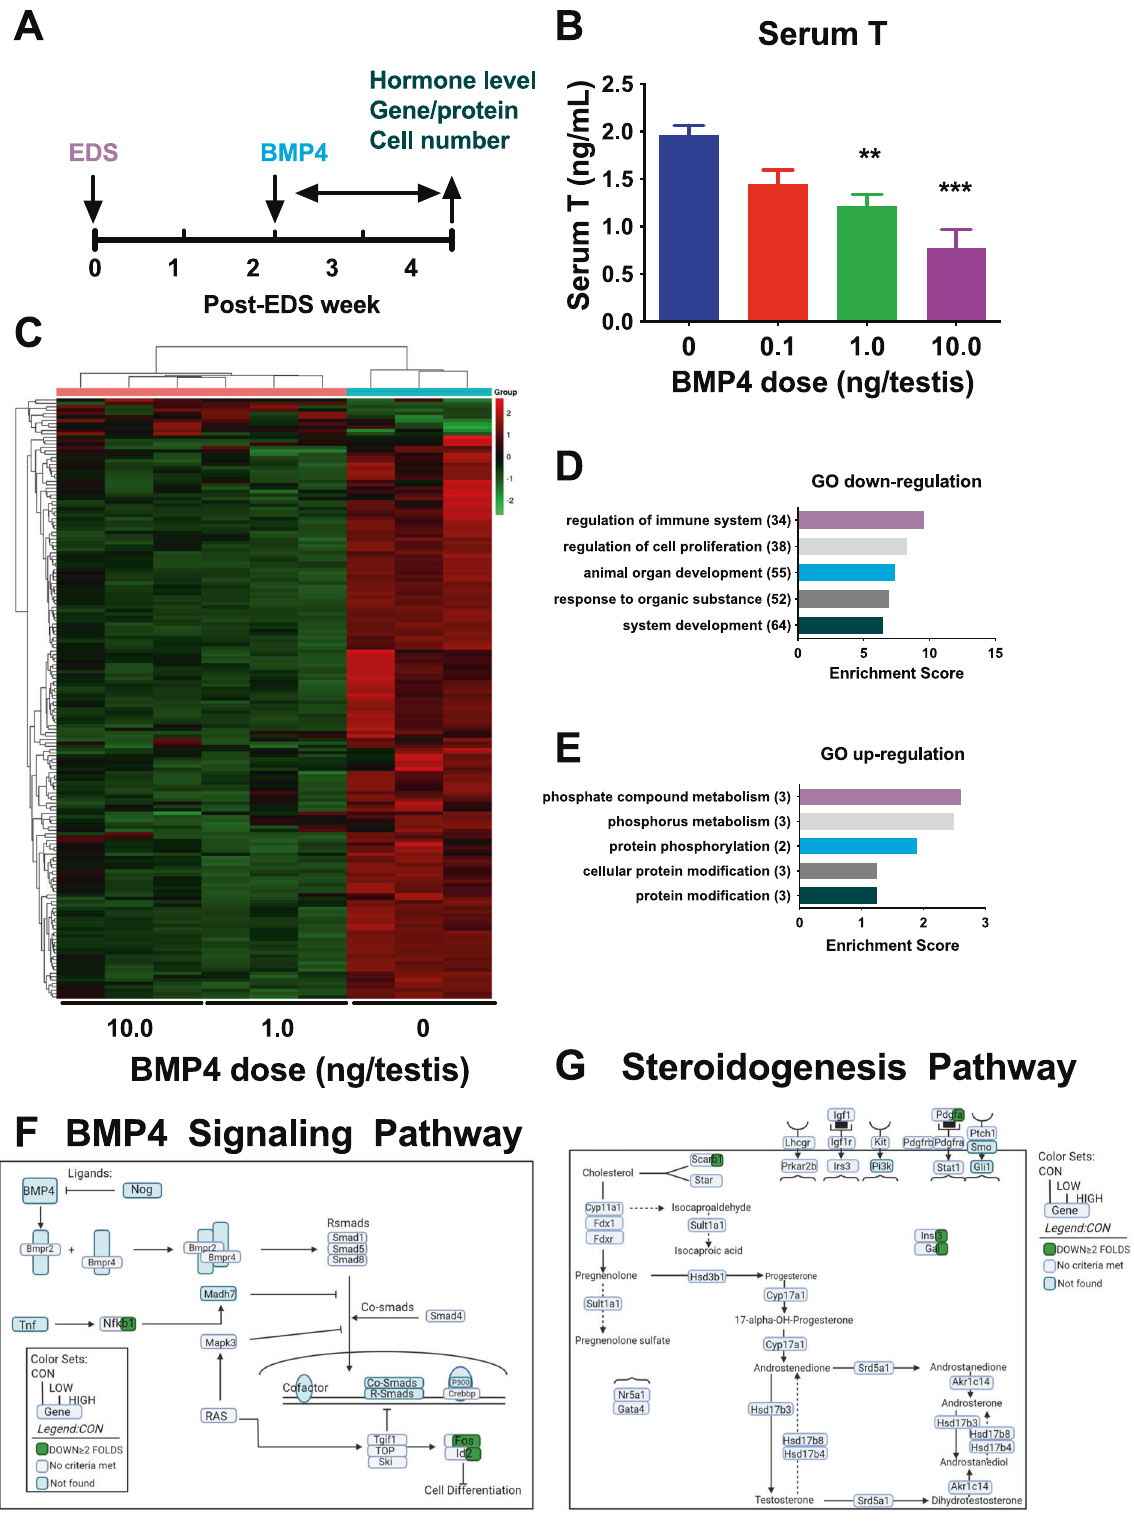
Fig. 7 Serum testosterone (T) levels and RNA-seq analysis BMP4-treated testis in vivo. A Animal protocol i.t. of 0, 0.1, 1, and 10 ng/testis BMP4 on day 14 to day 28 after EDS (ethanedimethane sulfonate); B Serum T levels, Mean ± SEM, n = 6; C mRNA HeatMap between BMP4 (1 and 10 ng/testis) and control (0 ng/testis) samples; red indicates upregulated genes, green indicates downregulated genes, mean ± SEM, n = 3; D downregulated gene GO, mean ± SEM, n = 3; E upregulated gene GO, mean ± SEM, n = 3; F BMP4 pathway; G steroidogenic pathway; Green indicates downregulated genes ≥ 2 fold, purple indicates genes not found. ** P < 0.01 and *** P < 0.001 indicate signi fi cant differences compared to control (0 ng/testis BMP4).